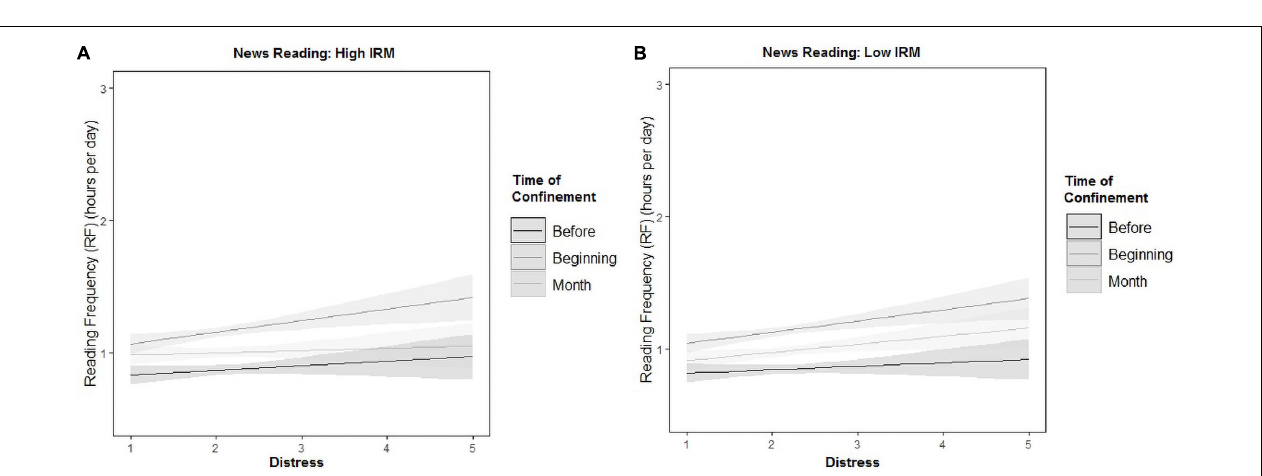
FIGURE 6 | Interaction between reading frequency (RF), distress, and time of confinement for high intrinsic reading motivation (IRM) (A) and low IRM (B) for news